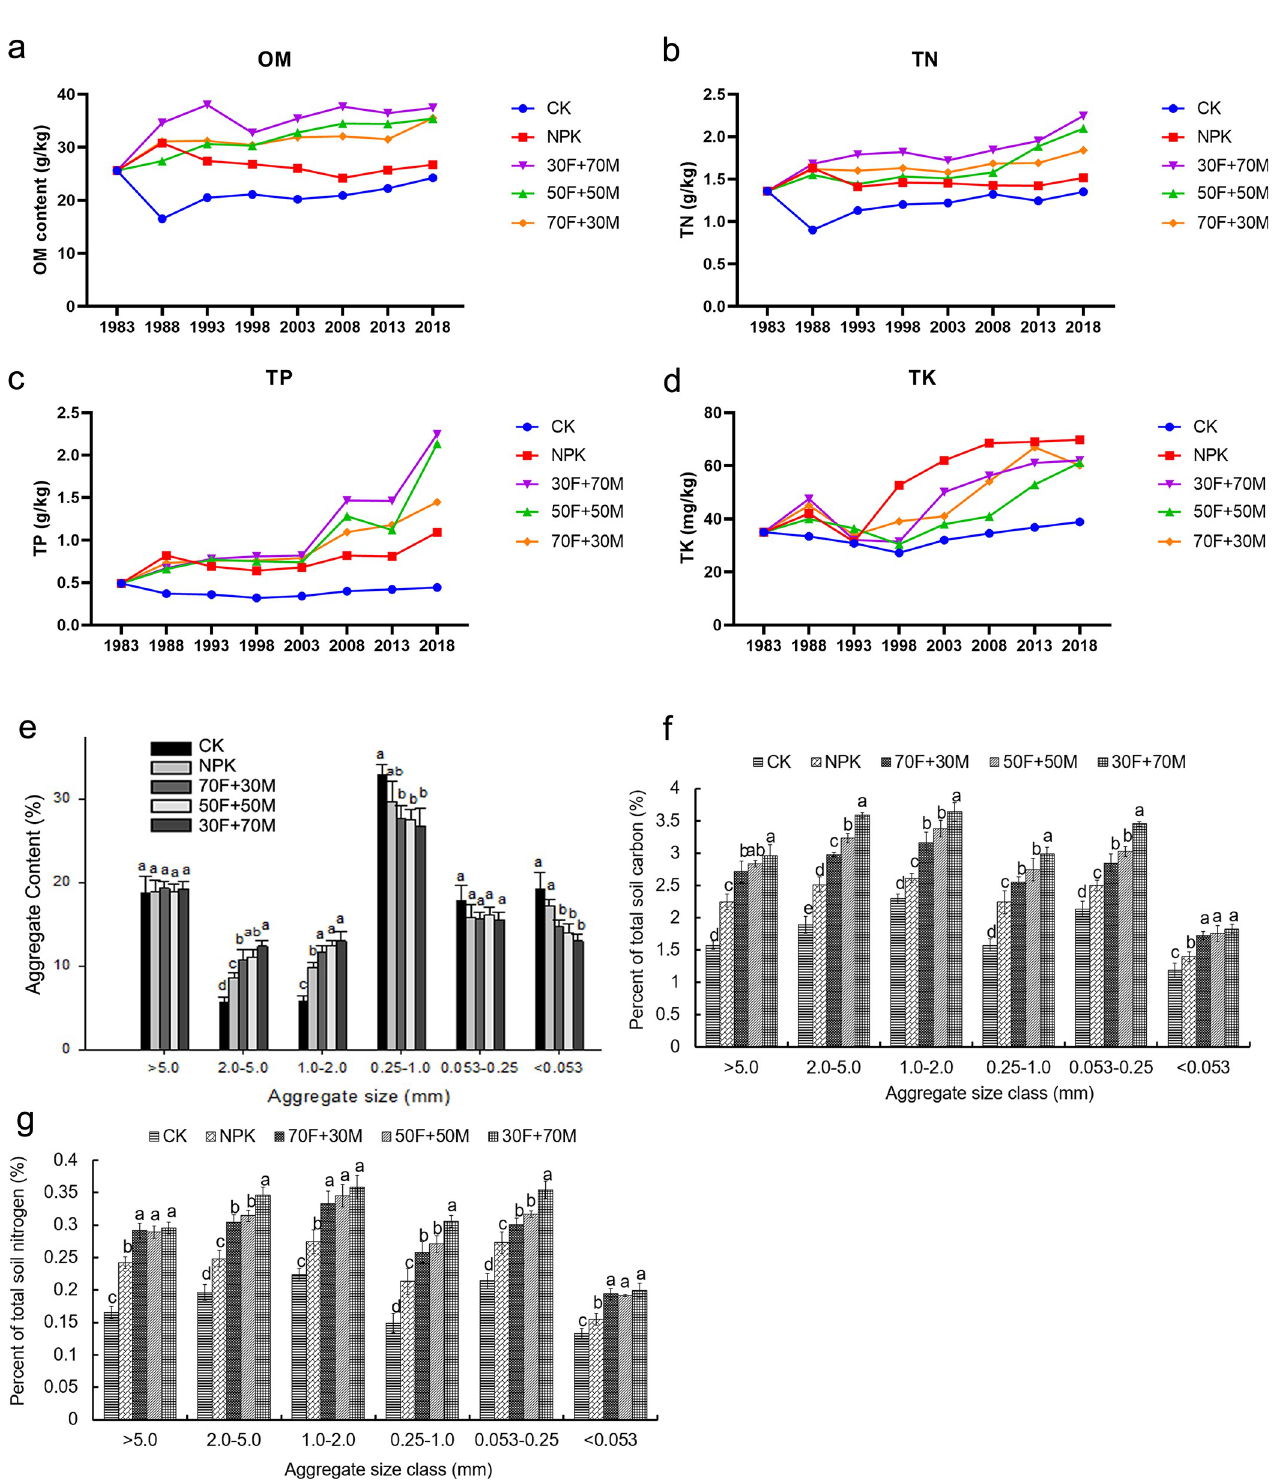
Fig 2. Impacts of various fertilizers on soil properties. ( a ) Dynamics of OM content from 1983 to 2012. ( b ) Proportion of water stable aggregates in different soil aggregate size class. ( c ) Percentage of total soil carbon in different soil aggregate size class. ( d ) Percentage of total soil nitrogen in different soil aggregate size